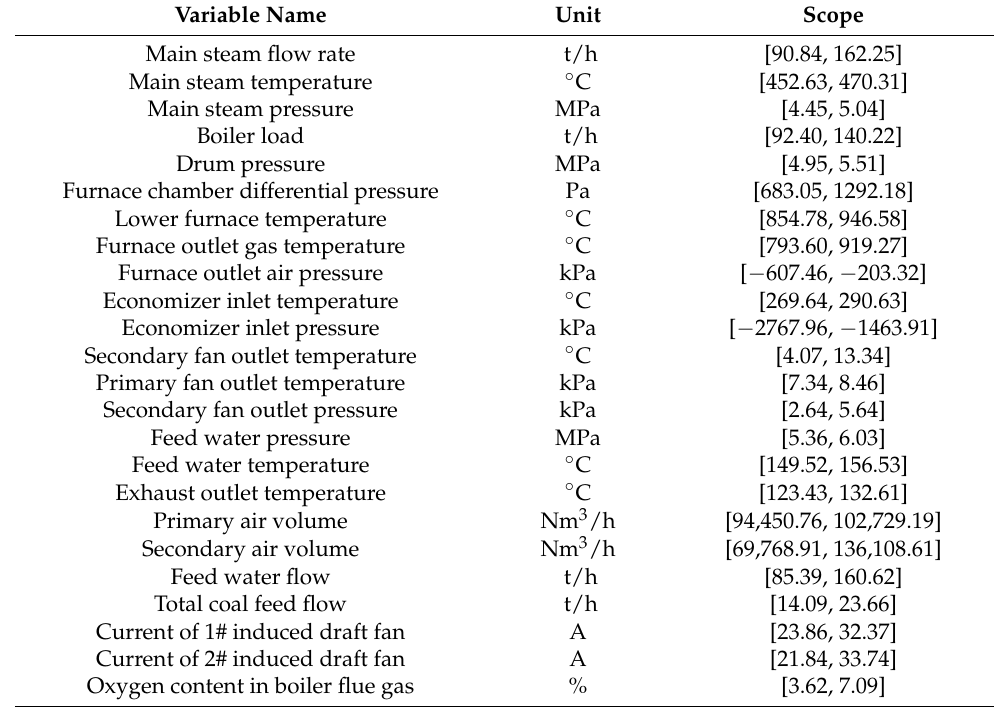
Table 1. Variables of the 130 t/h CFB